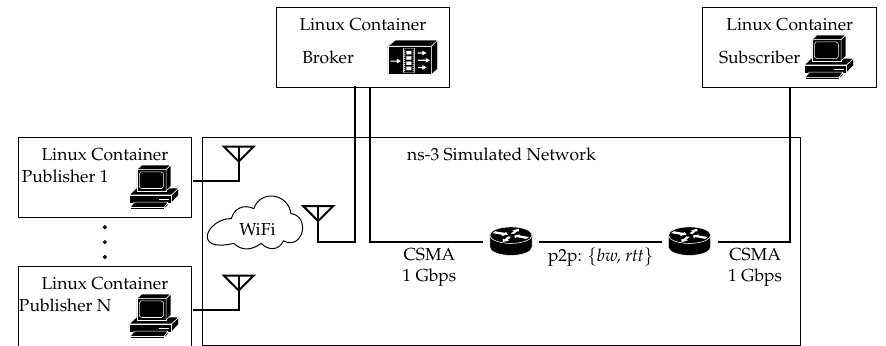
Figure 5. Scenario B. Various publishers connect to the broker over a shared WiFi